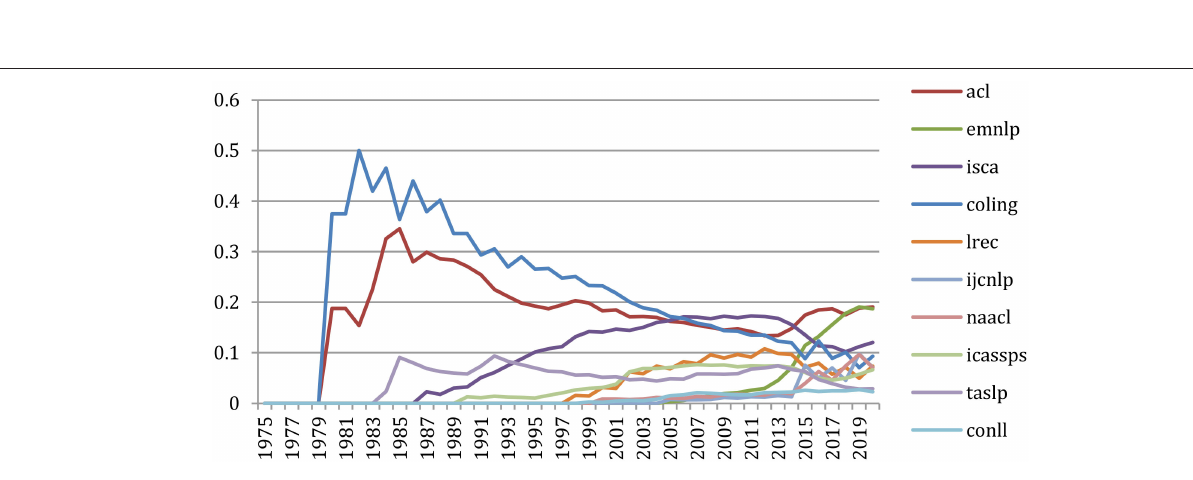
Frontiers in Research Metrics and Analytics | www.frontiersin.org 38 July 2022 | Volume 7 | Article